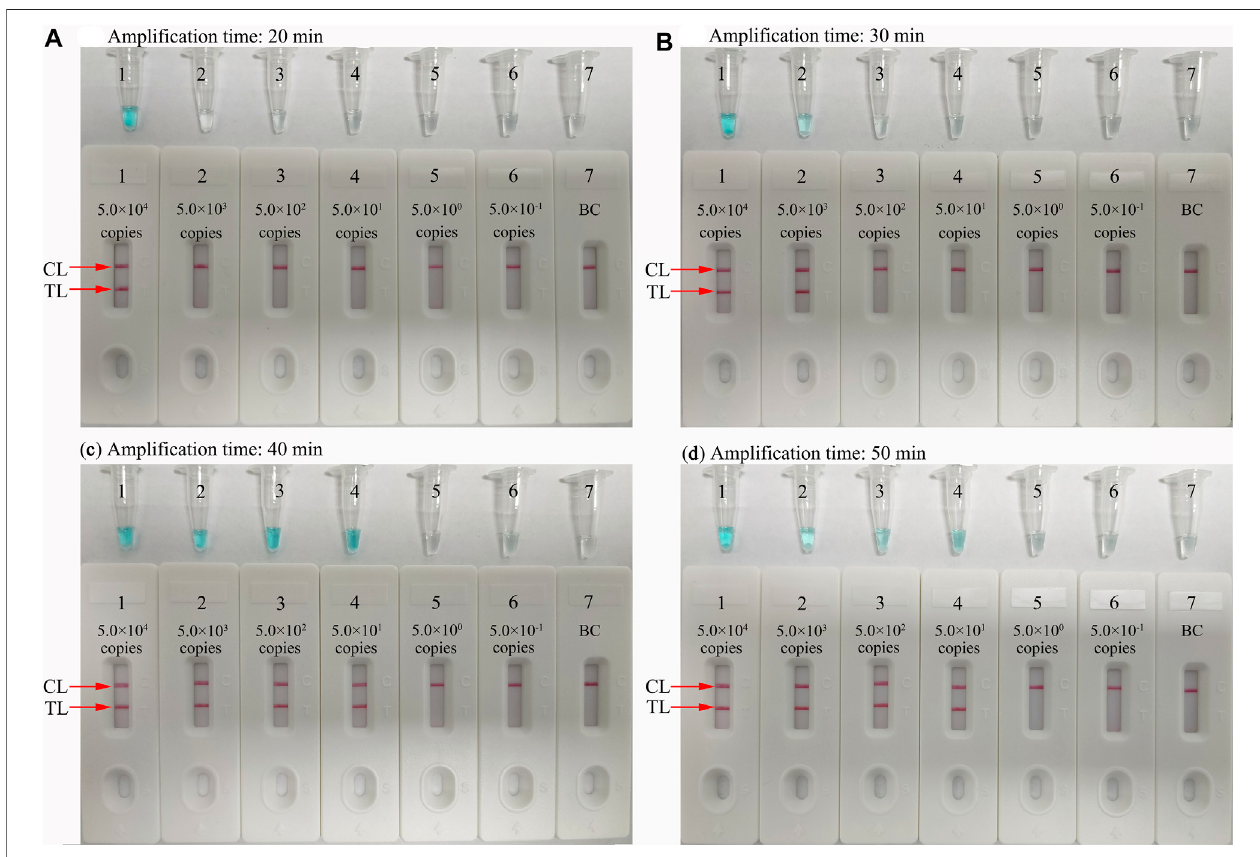
FIGURE 6 | Optimal reaction time for the N. gonorrhoeae -LAMP-PNB assay. Four different ampli fi cation times ( A , 20 min; B , 30 min; C , 40 min; D , 50 min) were tested at 64 ° C. Tubes/Biosensors 1, 2, 3, 4, 5, 6, and 7 represent N. gonorrhoeae (ATCC 49926) genomic DNA levels from 5.0 × 10 4 to 5.0 × 10 − 1 copies per reaction and negative control (DW), respectively. The results indicated that the best sensitivity was detected when the reaction lasted for 40 min (C) . CL: control line; T: test